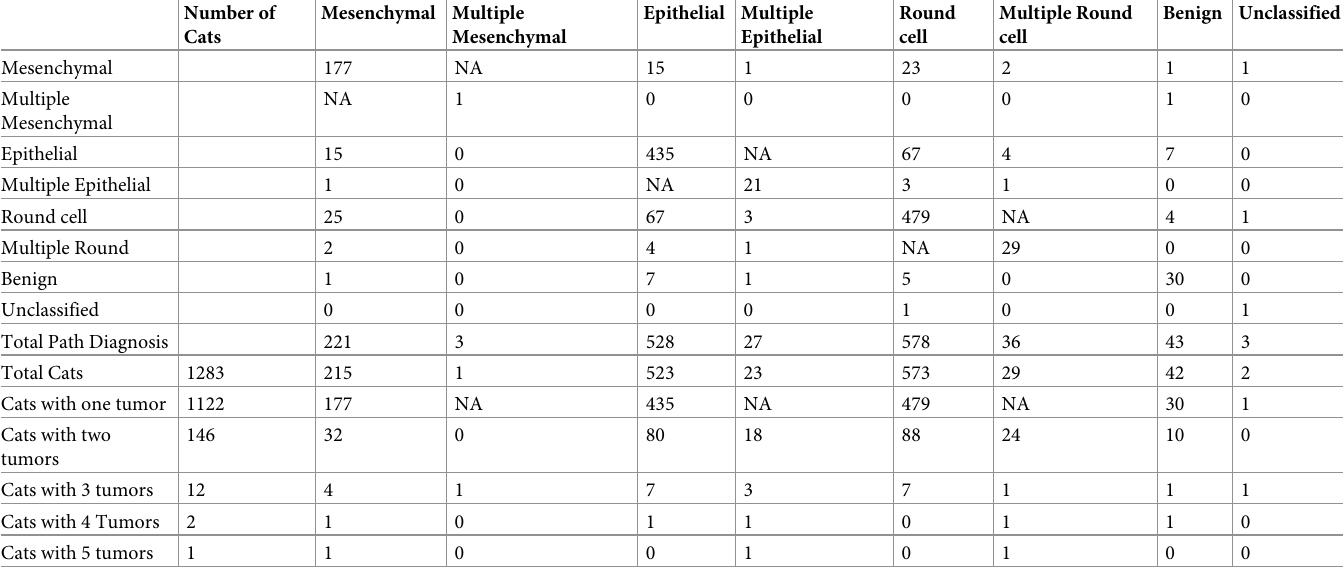
Table 3. Frequency of occurrence of tumor types and number of tumors seen in each